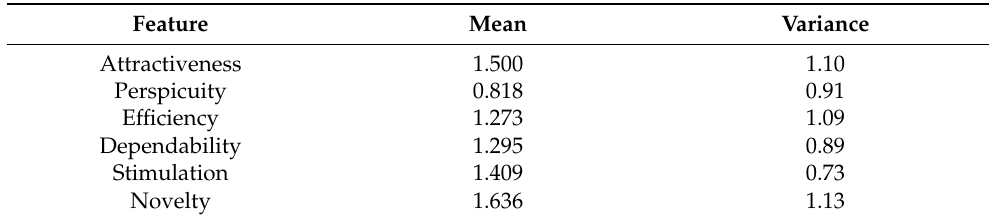
Table 5. Third training course—UEQ scales (mean and variance).